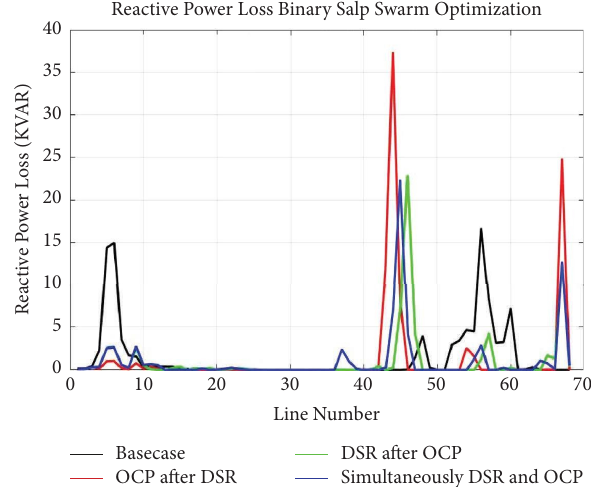
Figure 19: Reactive losses curve for 69-bus with using the BSSA algorithm for three scenarios with the base